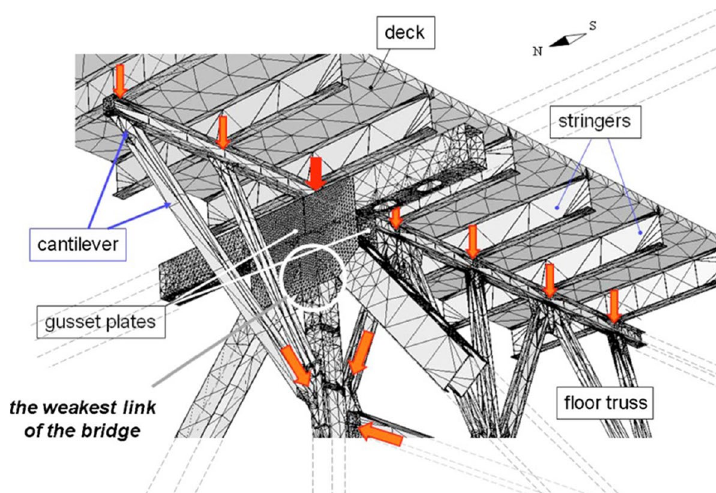
Fig. 6 The force transmission path of I-35w bridge (from Hao